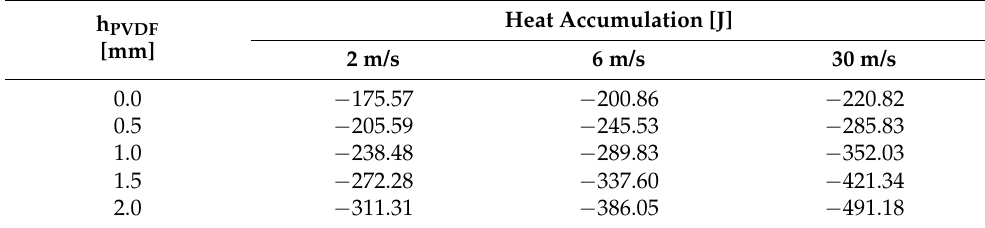
Table 3. Heat accumulation during the heating process of the core shell